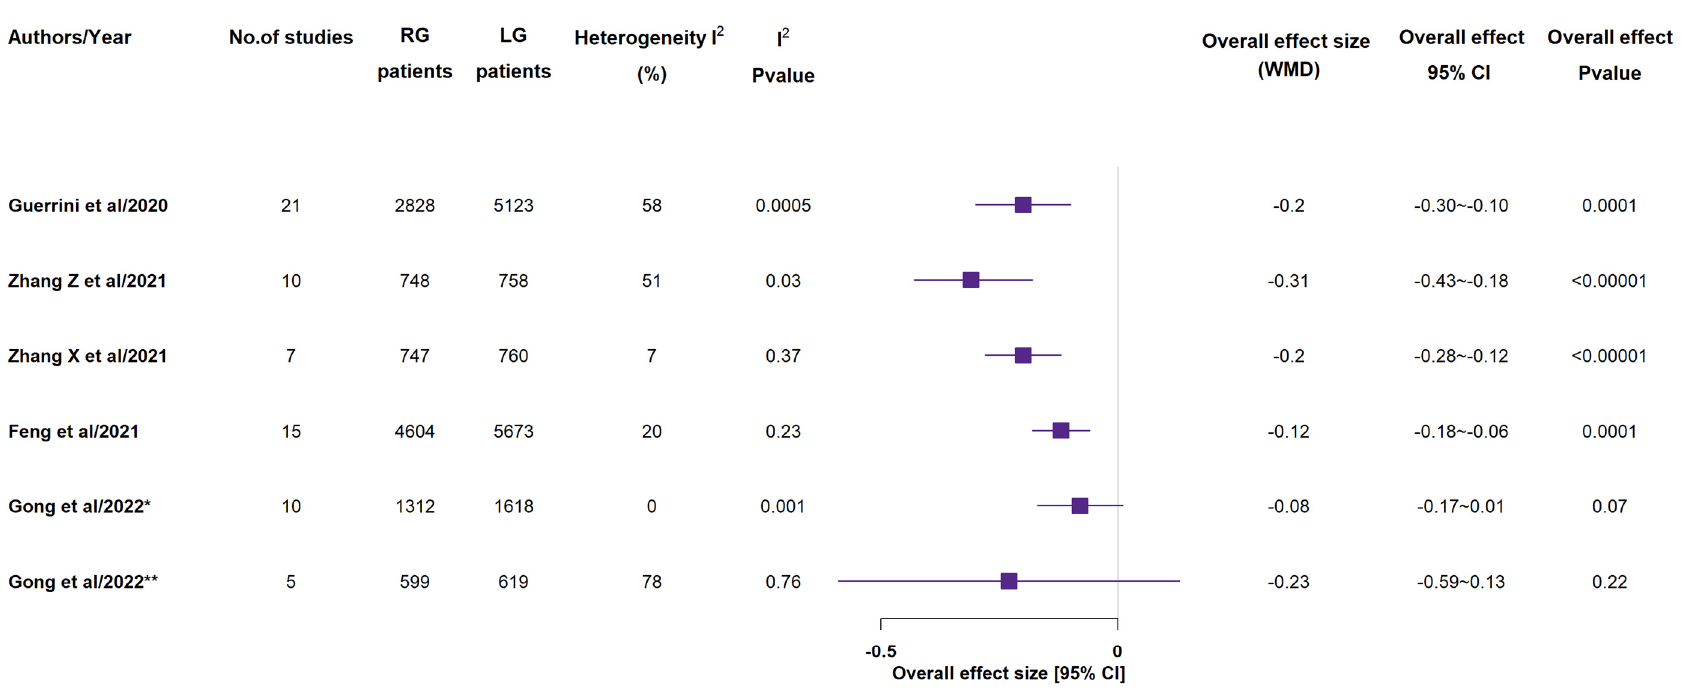
Figure 6. Time to restart oral intake (days). RG = Robotic gastrectomy; LG = Laparoscopic gastrectomy; WMD = weighted mean difference; * liquid diet; ** solid soft diet